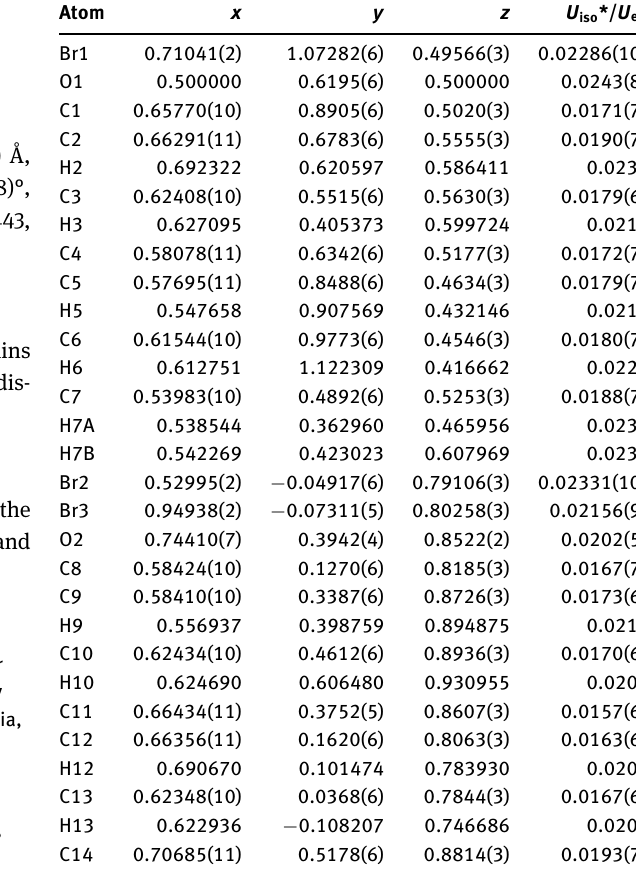
Table 2: Fractional atomic coordinates and isotropic or equivalent isotropic displacement parameters (Å 2